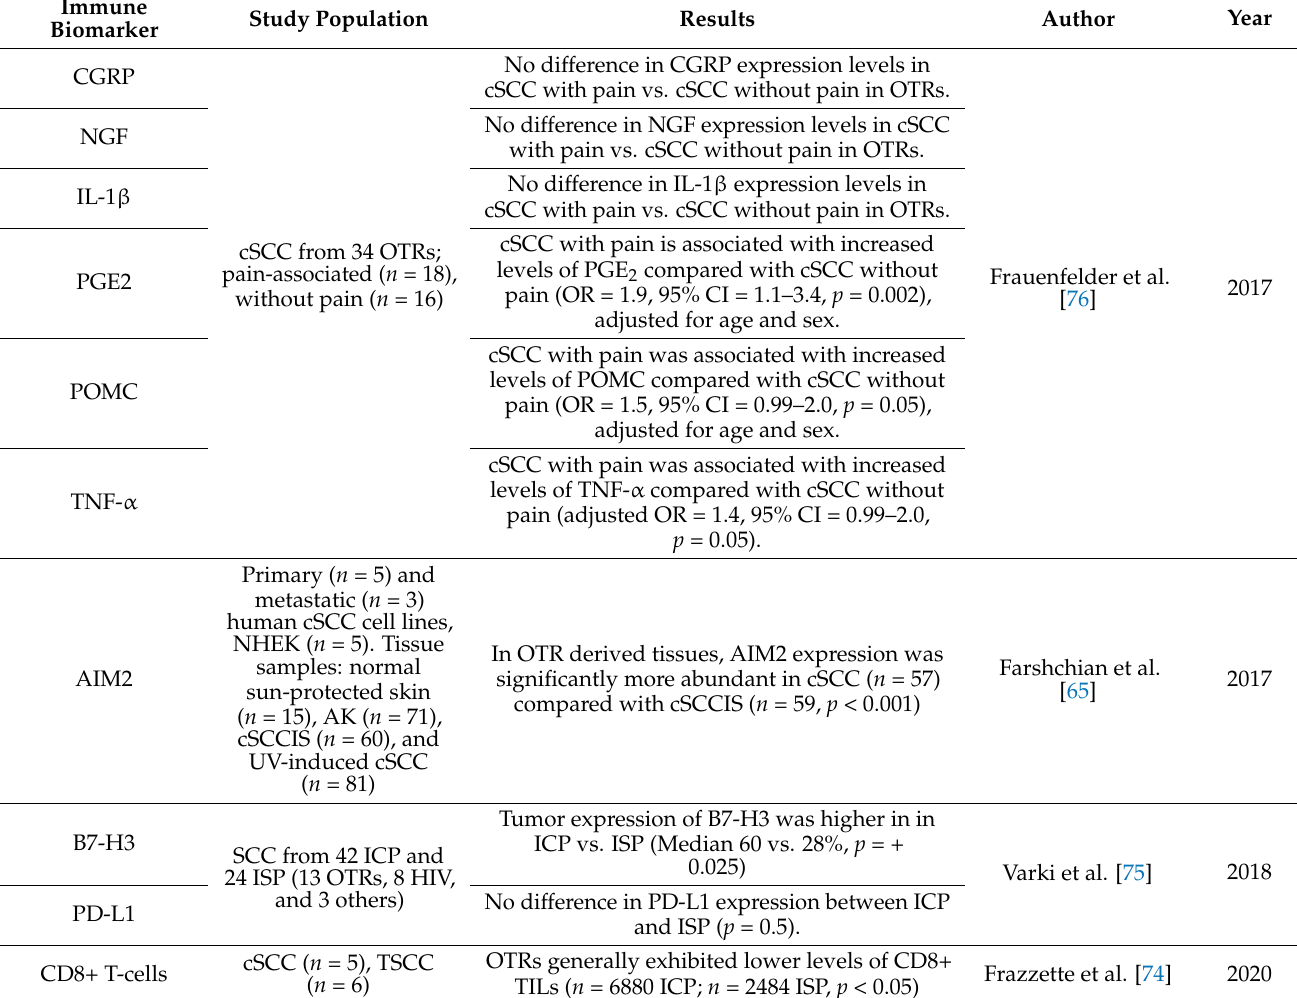
Table 7. The immune microenvironment of cSCC in the